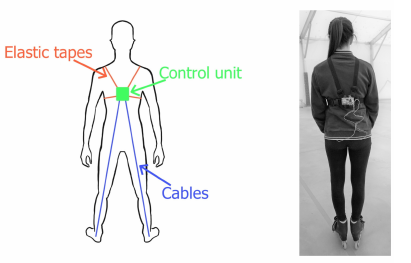
Figure 3. The positioning of the control unit on the